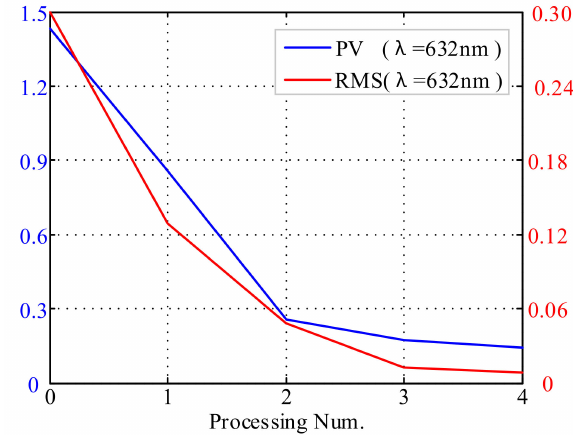
Figure 10. Convergence curves of the form